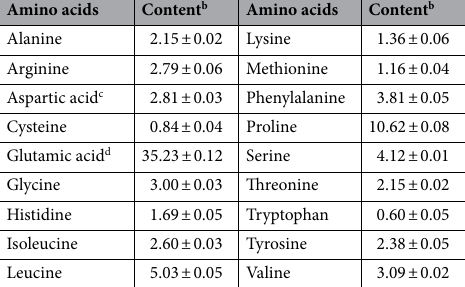
Table 1. Amino acid composition (dry basis) of WOP (%) a . a Data correspond to the average and standard deviation of three independent experiments. b The content of amino acids in WOP. c Aspartic acid + asparagine. d Glutamine acid +